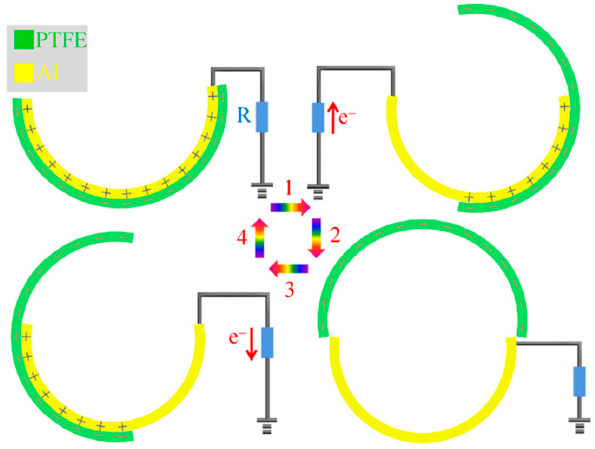
Figure 11. Stages of the operation principle of the TENG used in the hybrid energy cell fabricated by Wu et al. [157]. Reprinted with permission from [157]. Copyright ©2014, Tsinghua University Press and Springer-Verlag Berlin Heidelberg.